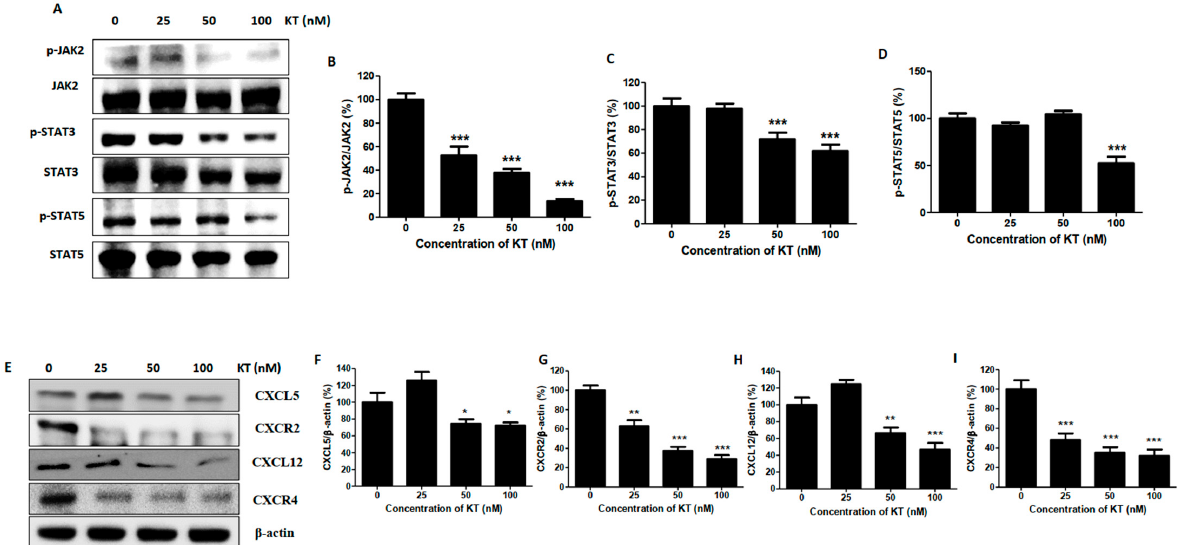
Figure 3. KT suppresses JAK2/STAT3 pathways and abrogates secondary cancer cell growth on bone. C. ( A ) Western blot analysis was performed to determine the expression of JAK2/STAT3 proteins. ( B – D ) Quantitative analysis of related protein expression. ( E ) Protein expression of secondary cancer cell growth factors on bone. ( F – I ) Quantitative analysis of the secondary growth stimulator of cancer cells on bone proteins. Results are presented as means ± S.D. ( n = 5). * p < 0.05, ** p < 0.01, and *** p < 0.001 indicate significant differences between KT-treated groups and control.